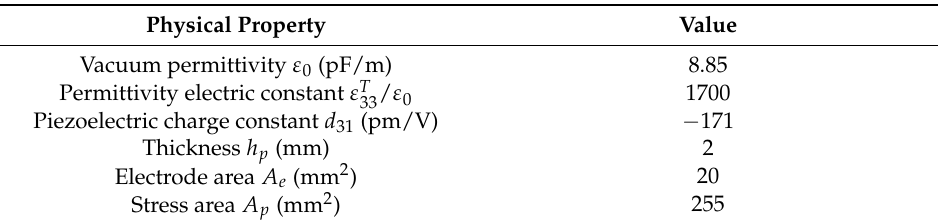
Figure 11. ( a ) C lp and corresponding voltage response versus time for U = 2.6 m/s and L ∗ = 2; ( b ) RMS of voltage response for different plate lengths under various velocities. All loads were 10 M Ω . Table 3. Major properties for adopted piezoelectric